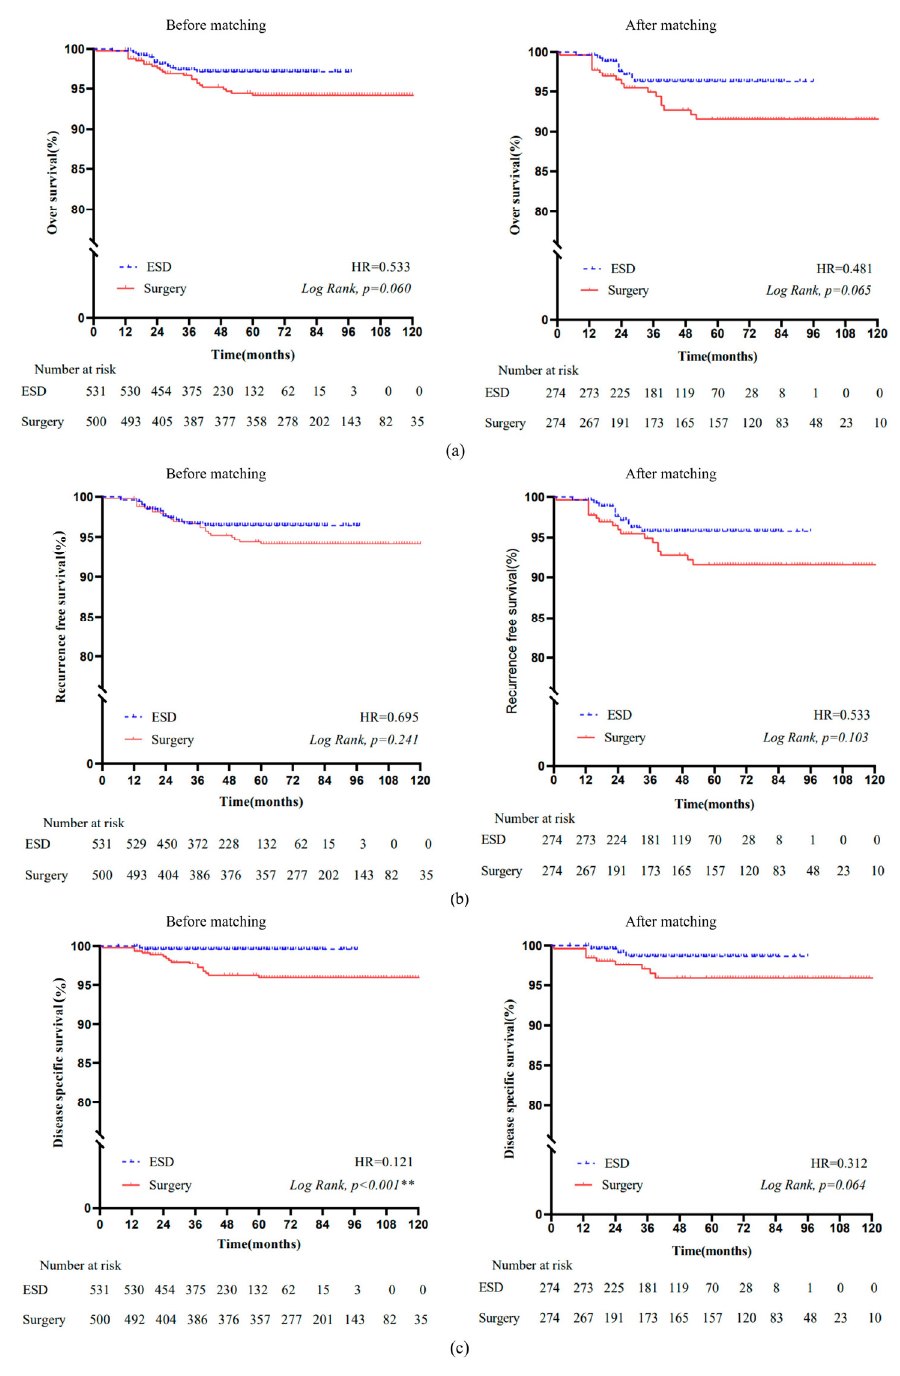
Figure 2. Kaplan–Meier survival curves of OS, RFS, and DSS in ESD and surgery groups. ( a ) OS before and after matching; ( b ) RFS before and after matching; ( c ) DSS before and after matching. Abbreviations: OS, overall survival; RFS, recurrence-free survival; DSS, disease-specific survival. **: p < 0.001